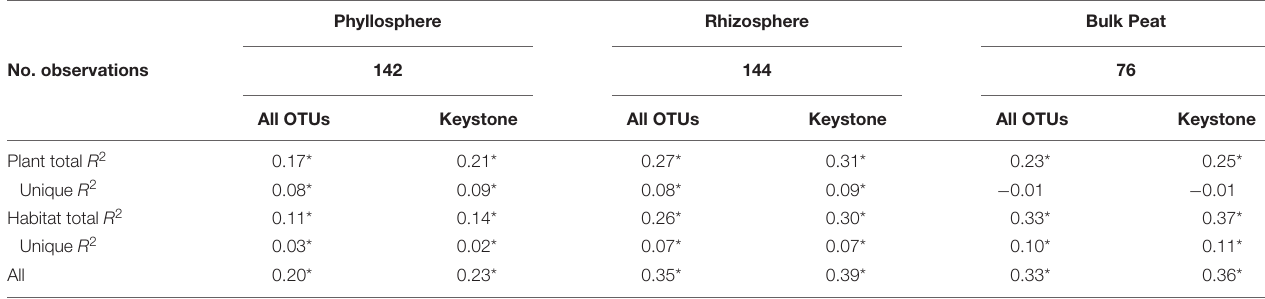
TABLE 2 | Variance partitioning by compartment based on Bray–Curtis distance between communities considering each compartment (phyllosphere, rhizosphere, and bulk peat) separately. Phyllosphere Rhizosphere Bulk